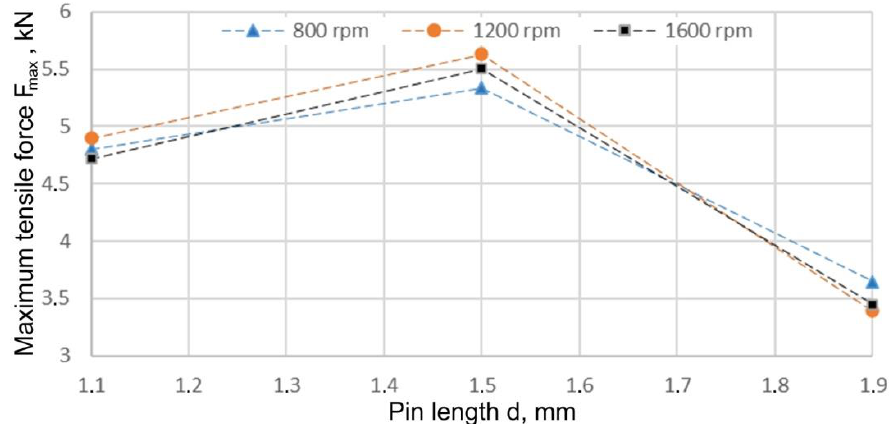
Figure 13. Effect of pin length and tool rotational speed on maximum force transmitted by the joint F max (x 2 = 200 mm/min).